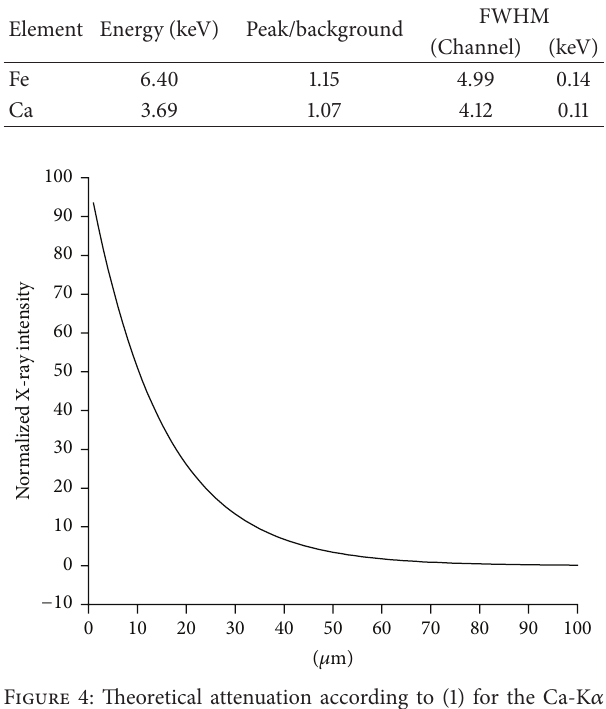
Table 1: Average values for the ratio peak/background and FWHM for the glass substrate number 5.